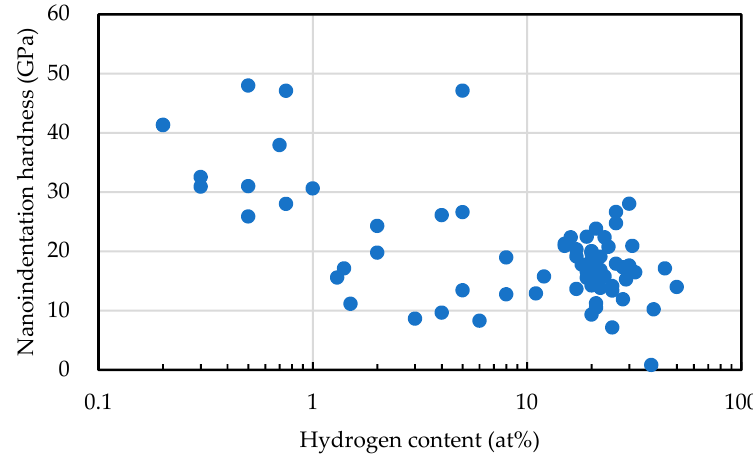
Figure 15. Nanoindentation hardness vs. hydrogen content of amorphous carbon films.